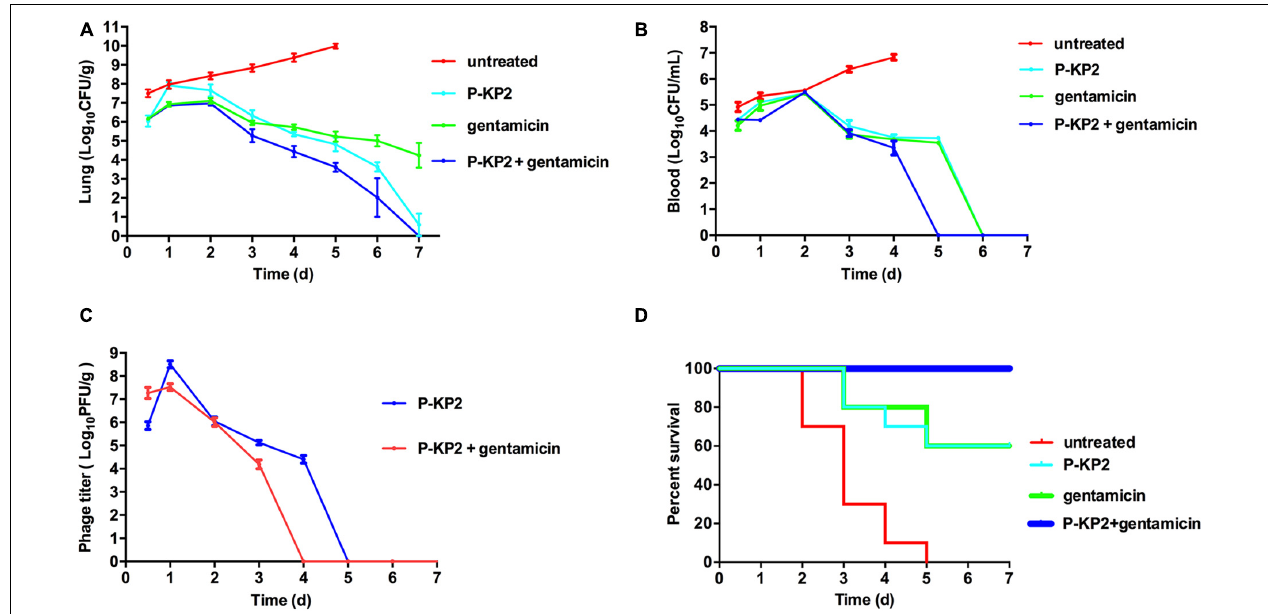
FIGURE 6 | Therapeutic effects of P-KP2 and gentamicin on K. pneumoniae in vivo . All the mice were challenged intranasally with 1.0 × 10 9 CFU/mouse of K. pneumoniae W-KP2. After 1 h post infection, they were intranasally treated with P-KP2 (1.0 × 10 9 PFU/mouse), gentamicin (1.5 mg/kg), or phage-antibiotic combination (gentamicin was administered intranasally at 30 min after P-KP2 administration), respectively. The untreated group was administered with PBS under the same conditions. (A) Bacterial loads in the lungs. At every 24 h (lasting for 7 days) after W-KP2 infection, the right lungs of the euthanized mice in each group were carefully separated, weighed and homogenized. Then the bacterial loads in the lung homogenates were detected after serial dilution ( n = 3). (B) Bacterial loads in blood. Peripheral blood samples (10 µ L) were obtained from the caudal veins of the anesthetized mice ( n = 3). (C) Phage titers in the lungs. Phage titers of lung homogenates of each group were detected after serial dilution ( n = 3). The above data represent the mean ± SEM of triplicate experiments. (D) Survival rates. Survival rates of W-KP2-infected mice in each group were determined. Each group contained ten mice. Statistical analysis was performed using the Kaplan-Meier method [ P < 0.0001, log-rank (Mantel-Cox)